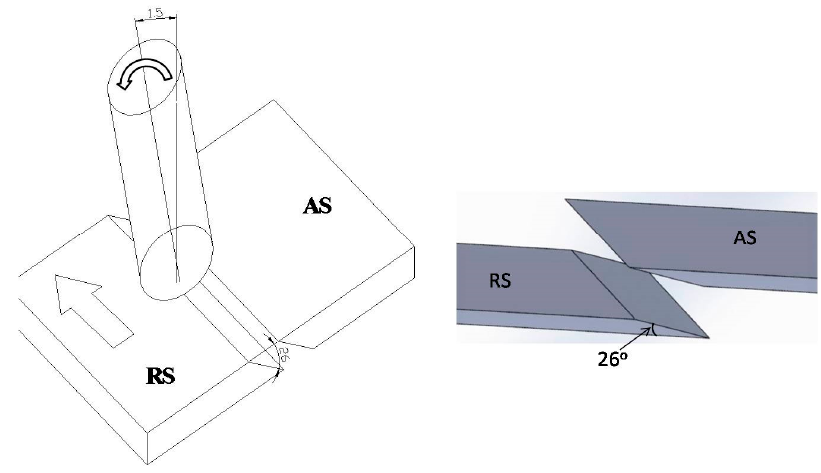
Figure 4. Alignment of plates for scarf joint configurations.